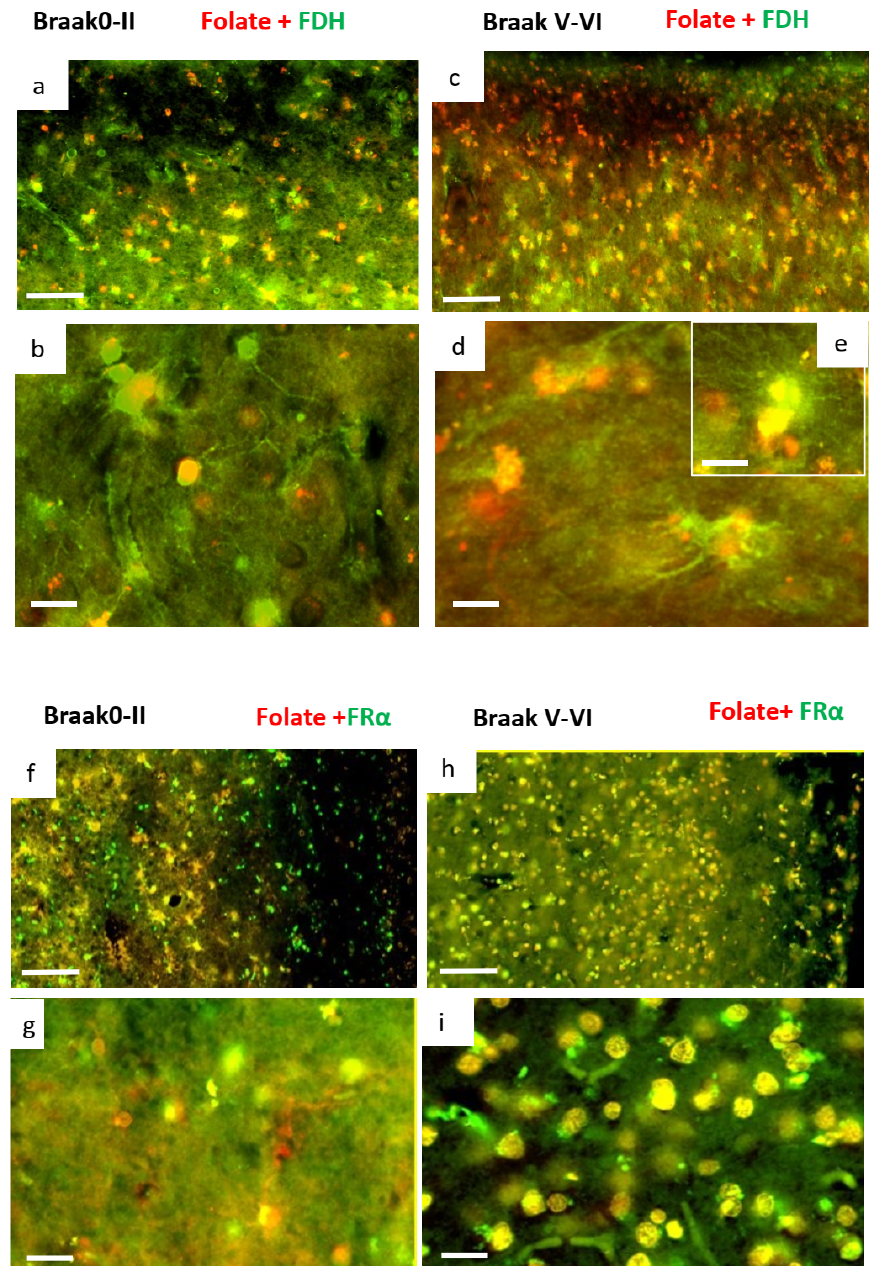
Figure 6. Immunofluorescence staining for folate, FR α and FDH. Double immunofluorescence stain- ing for FDH (green) and folate (red) in neurologically normal (( a ) 100 × 100 µ m and ( b ) 400 × 20 µ m) and AD brain (( c ) 100 × 100 µ m and ( d ) 400 × 20 µ m). Some co-localisation (yellow) of folate and FDH (( e ) 400 × 20 µ m) is observed. Double immunofluorescence staining for FR α (green) and folate (red) in normal (( f ) 100 × 100 µ m and ( g ) 400 × 20 µ m) and AD brain (( h ) 100 × 100 µ m and ( i ) 400 × 20 µ m). The figure is representative of neurologically normal n = 3 and AD n = 4